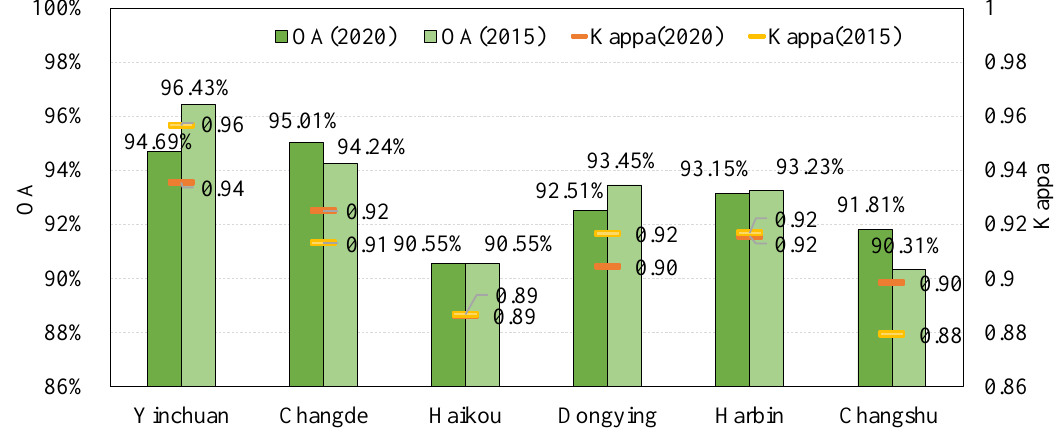
Figure 2. Overall accuracy (OA) and the Kappa coefficient in 6 cities.